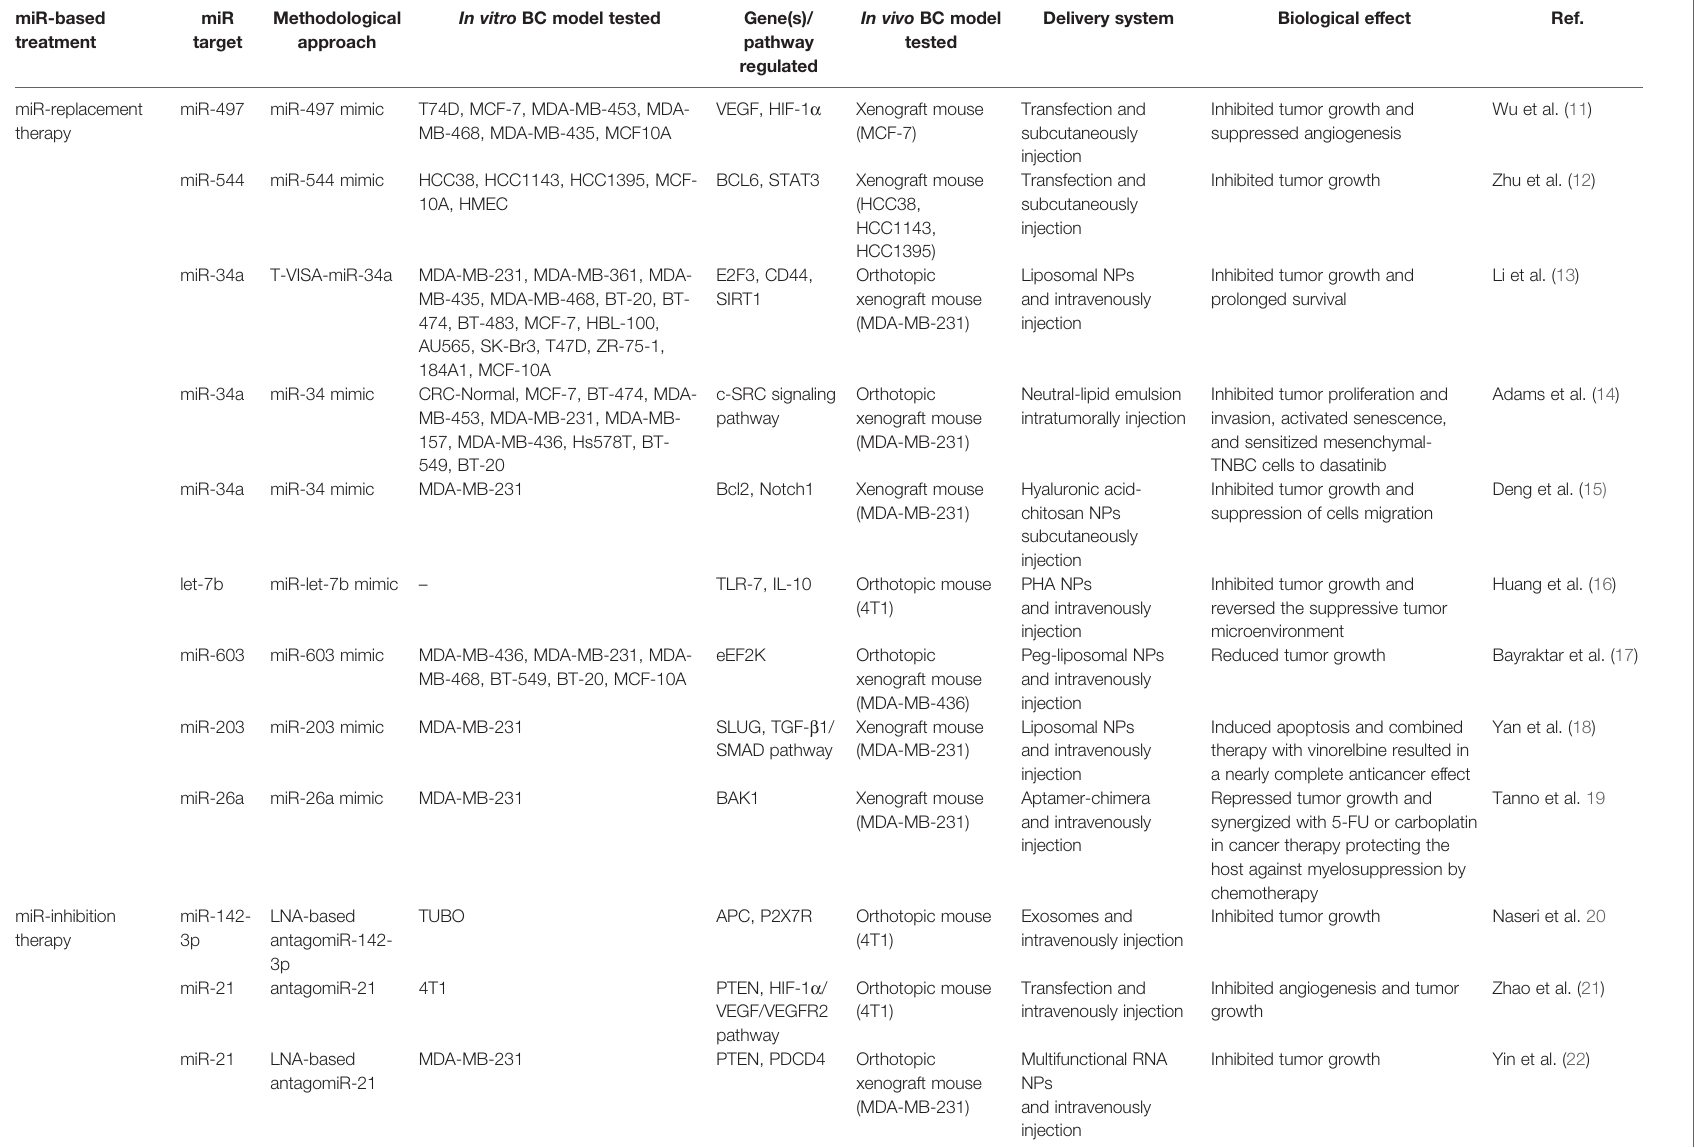
TABLE 1 | miR-based therapy and their role as anticancer drugs in BC